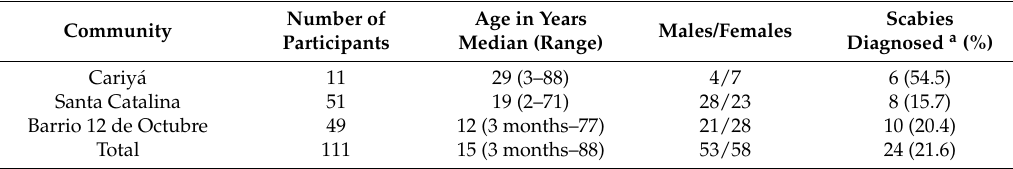
Table 1. Demographic characteristics of participants.